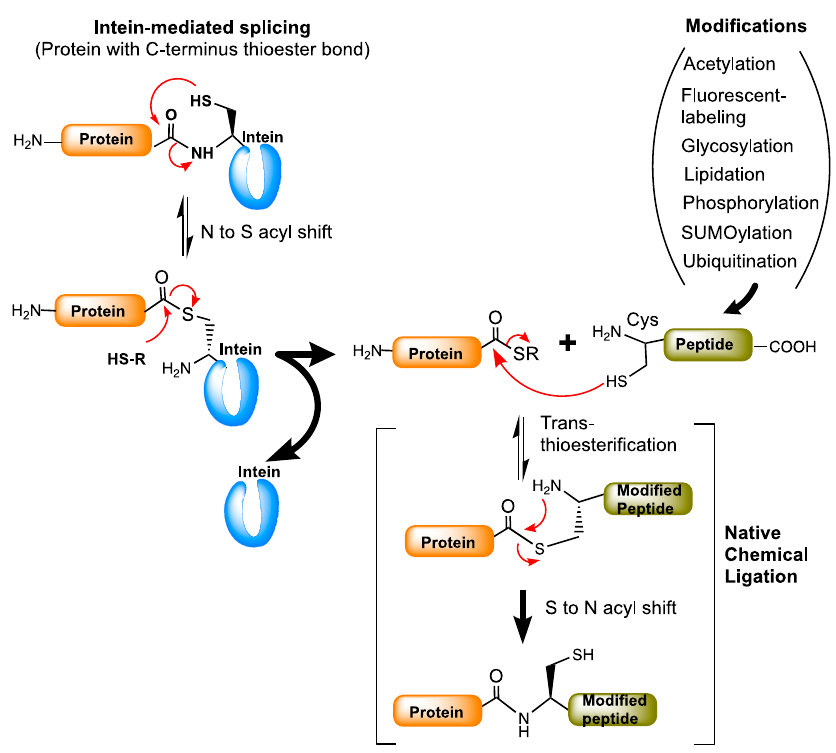
Figure 6. Protein modifications by expressed protein ligation (EPL). The protein of interest fused to the intein is expressed and purified in esterified form. The esterified protein is then attached to the modified peptides (or proteins) by trans-(thio)esterification process using native chemical ligation (NCL). Red arrows represent the chemical reaction/s between the functional groups indicated.